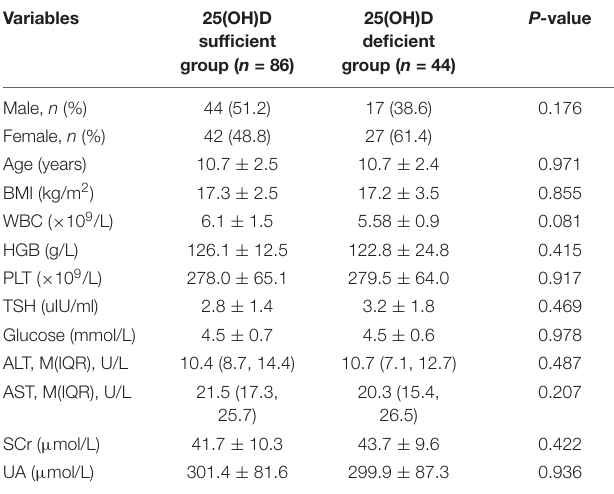
TABLE 2 | Demographic characteristics and laboratory findings of patients with vasovagal